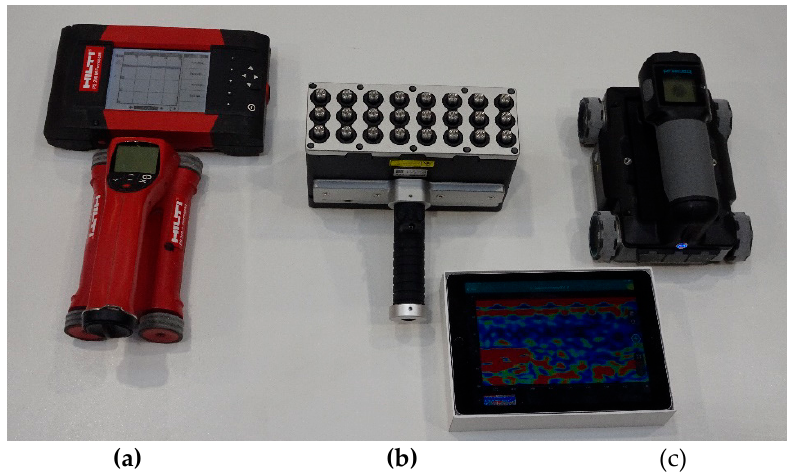
Figure3. Appliedmeasuringequipment, ( a )electromagneticscanner-PS200, ( b )ultrasonictomography - Pundit 250 Array, ( c ) radar scanner - GPR